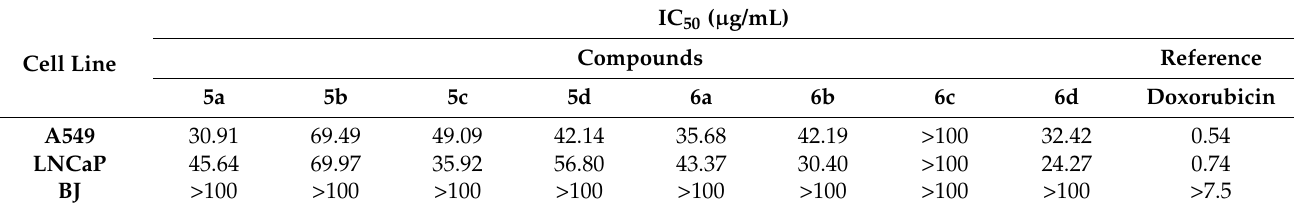
Table 10. Molecular properties of the compounds 5a – d and 6a – d with strong influence on their pharmacokinetics.